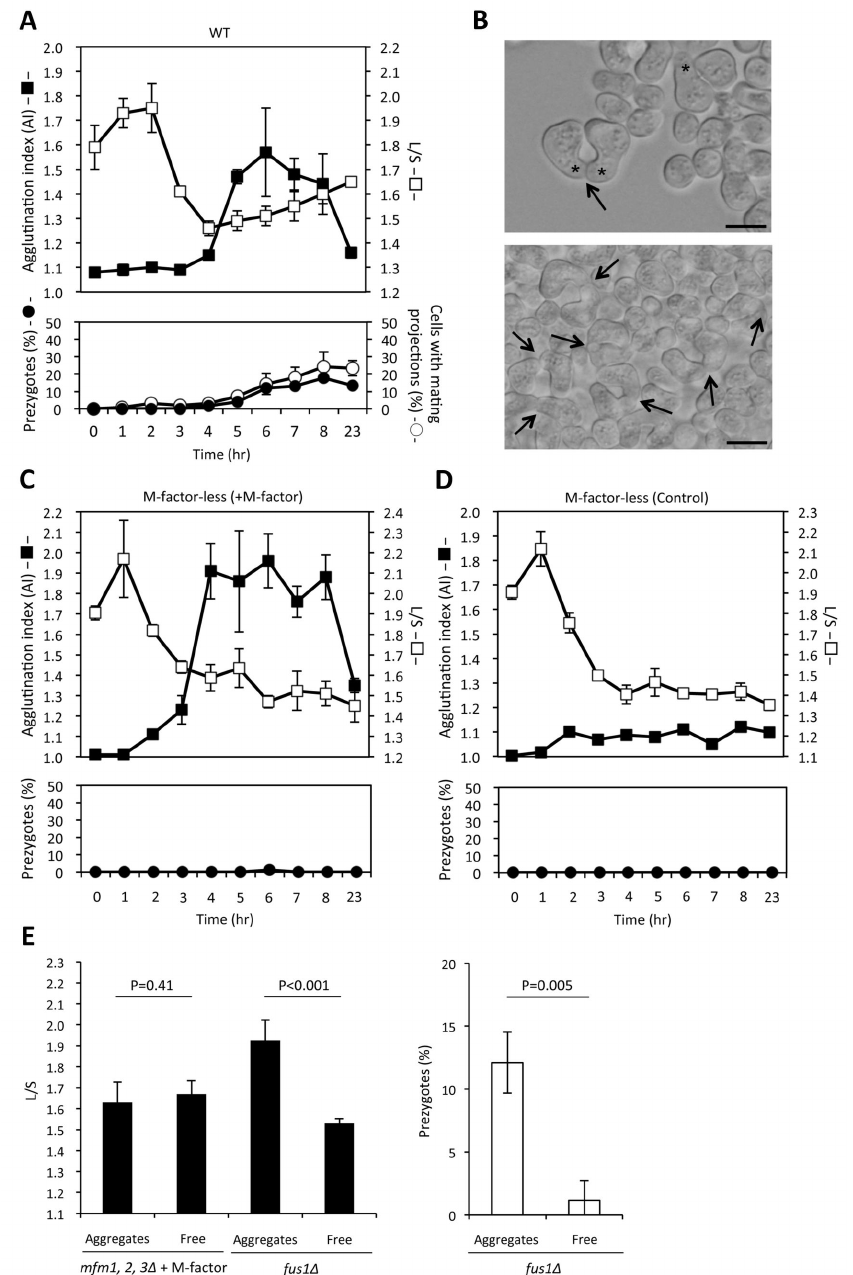
Figure 8. Kinetics of sexual agglutination and polar cell growth in liquid culture. (A) Mating kinetics of a homothallic wild-type strain (L968) cultured in SSL−N liquid medium. At hourly intervals, the intensity of agglutination (AI) was determined. Portions of the culture were subjected to brief sonication and microphotographs were taken. The long (L) and short (S) axes of cells were measured to calculate the L/S ratio for triplicate samples (100 cells each). The frequencies of prezygotes and cells with pointy projections were determined. (B) Microphotographs showing typical cell morphology. Arrows, prezygotes with a pointy mating projection (shown by asterisks). Scale bar, 10 µm. (C, D) Mating kinetics of M-factor-less mutant cells incubated with (C) or without (D) 200 nM M-factor. The experimental procedures are as described in (A). (E) Left, polar cell growth and prezygote formation in M- factor-induced aggregated cells and floating free cells. An M-factor-less strain (FS55) and an M-factor-producing fus1Δ strain (FS123) were incubated with 200 nM M-factor. After 4 hr, aggregates and free cells were isolated. After brief sonication, the L/S ratio was determined (n=1,000 for both strains). Right, frequency of prezygotes formed with fus1Δ (Aggregates vs Free: each p - value was shown, t -test).. doi: 10.1371/journal.pone.0069491.g008 PLOS ONE |